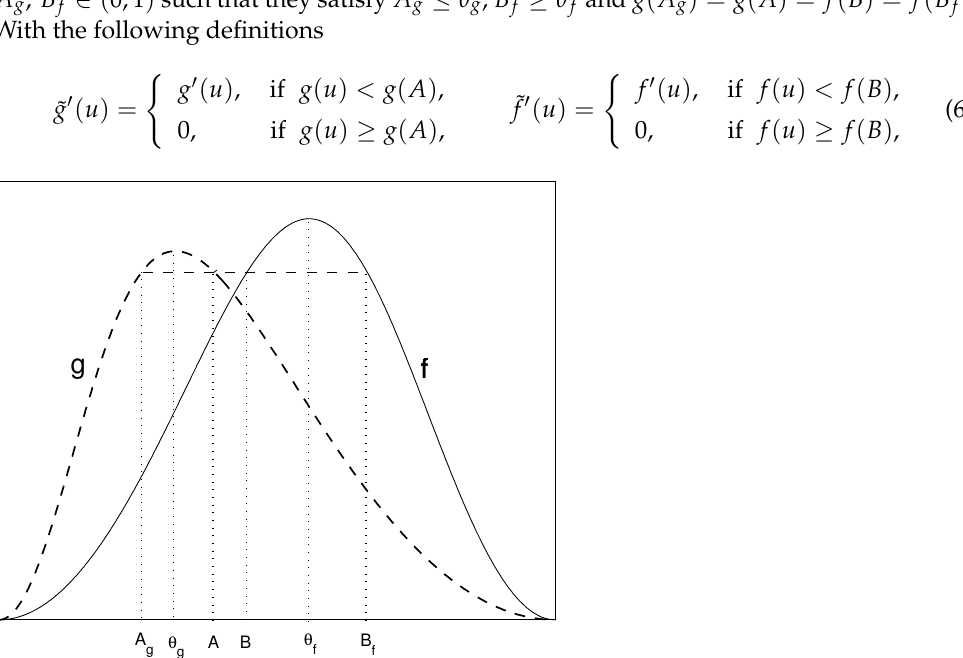
Figure 1. The graphs of functions f ( x ) and g ( x ) and the ( A , B )